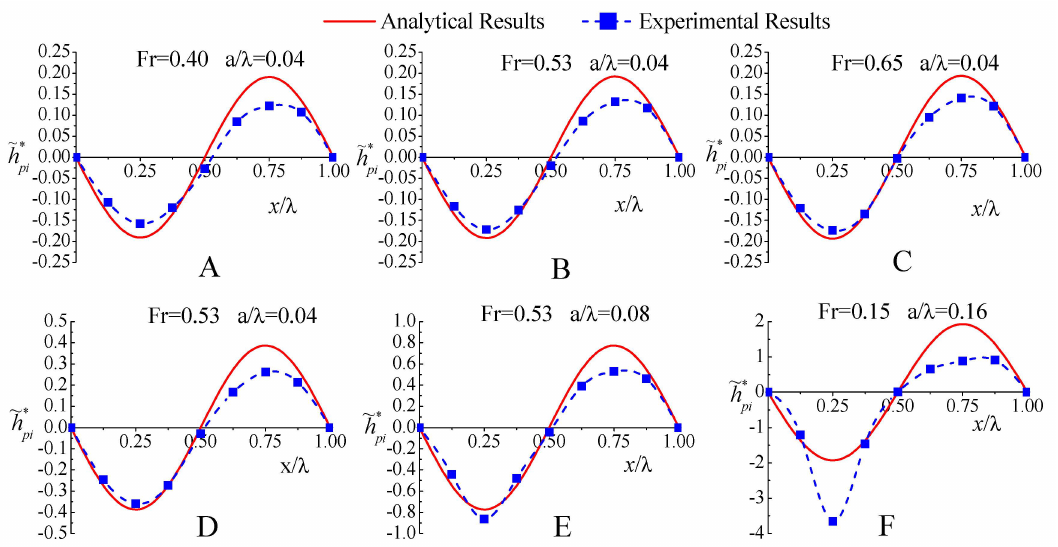
Figure 4. Comparison of analytical solution and experimental data for middle layer under different run cases, in which solid line and dotted dashed line represent the analytical solutions and the experimental data,